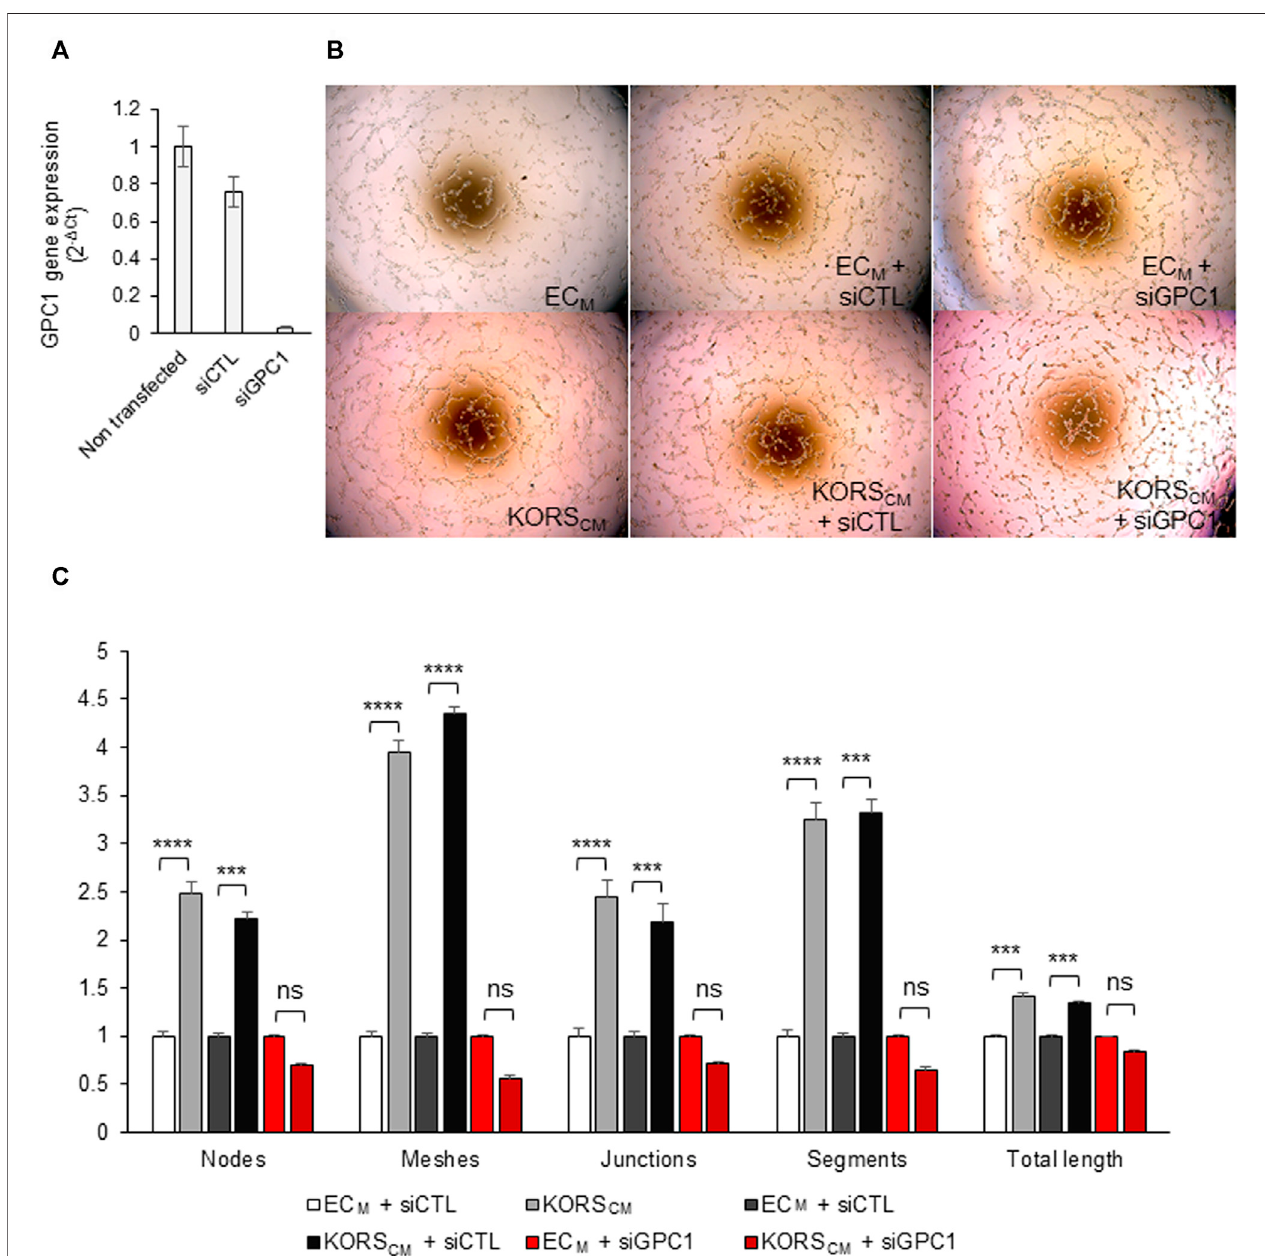
FIGURE6| DownregulationofGPC1geneexpressionbysiRNAabolishedtheKORS CM -inducedpseudotubeformationbyHDMEC. (A) GPC1geneexpressionin HDMEC were analyzed by RT-qPCR. (B,C) Pseudotube formation of non-transfected or transfected (siCTL or siGPC1) HDMECs after 5 h in EC M or KORS CM is illustrated (B) and the number of nodes, meshes, junctions, segments, and the total length were calculated and expressed asthe mean ± SEM, n (cid:2) 4 to8 replicates and three independent experiments (C) .